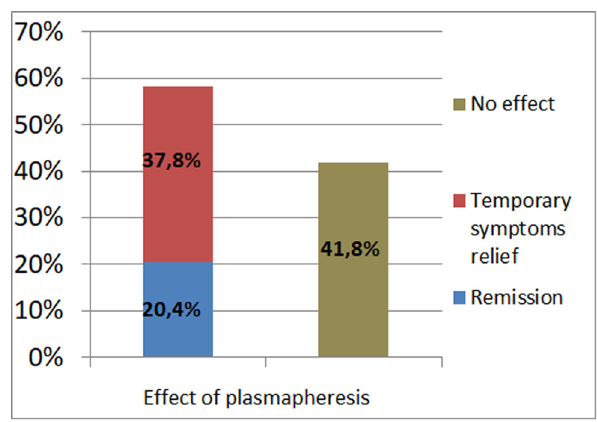
Figure 3: E ff ect of plasmapheresis.